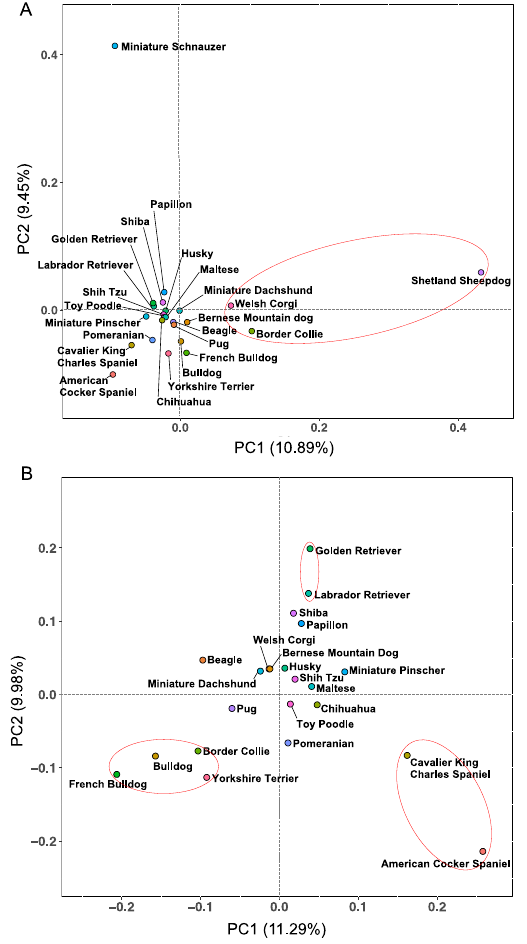
Figure 6. Principal component analysis based on 88-12/88L-DRB1 haplotype frequencies among 24 breeds. The analysis based on the frequency of three-locus DLA haplotypes in each allele at field-1 level among ( A ) 24 breeds listed in Table 5 and ( B ) 22 breeds except for Shetland Sheepdog and Miniature Schnauzer from ( A ) are represented. The breeds that shared a three-loci haplotype with relatively high frequency (See Section 3.6. in detail) are grouped with a red circle. The contribution ratio of the first (PC1) and second component (PC2) are described on the x - and y -axis in parentheses, respectively.